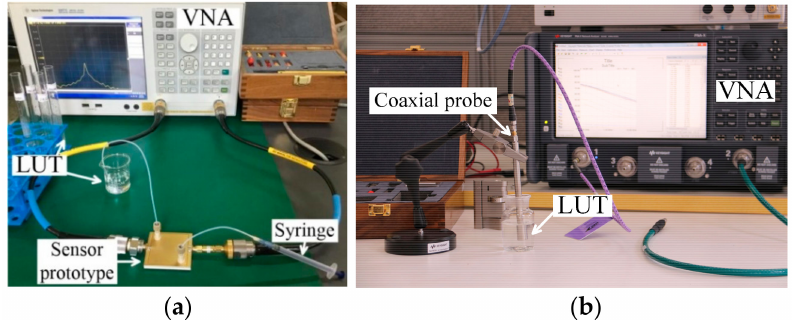
Figure 12. The measurement setup of ( a ) the proposed sensor in this work and ( b ) the Keysight coaxial probe kit